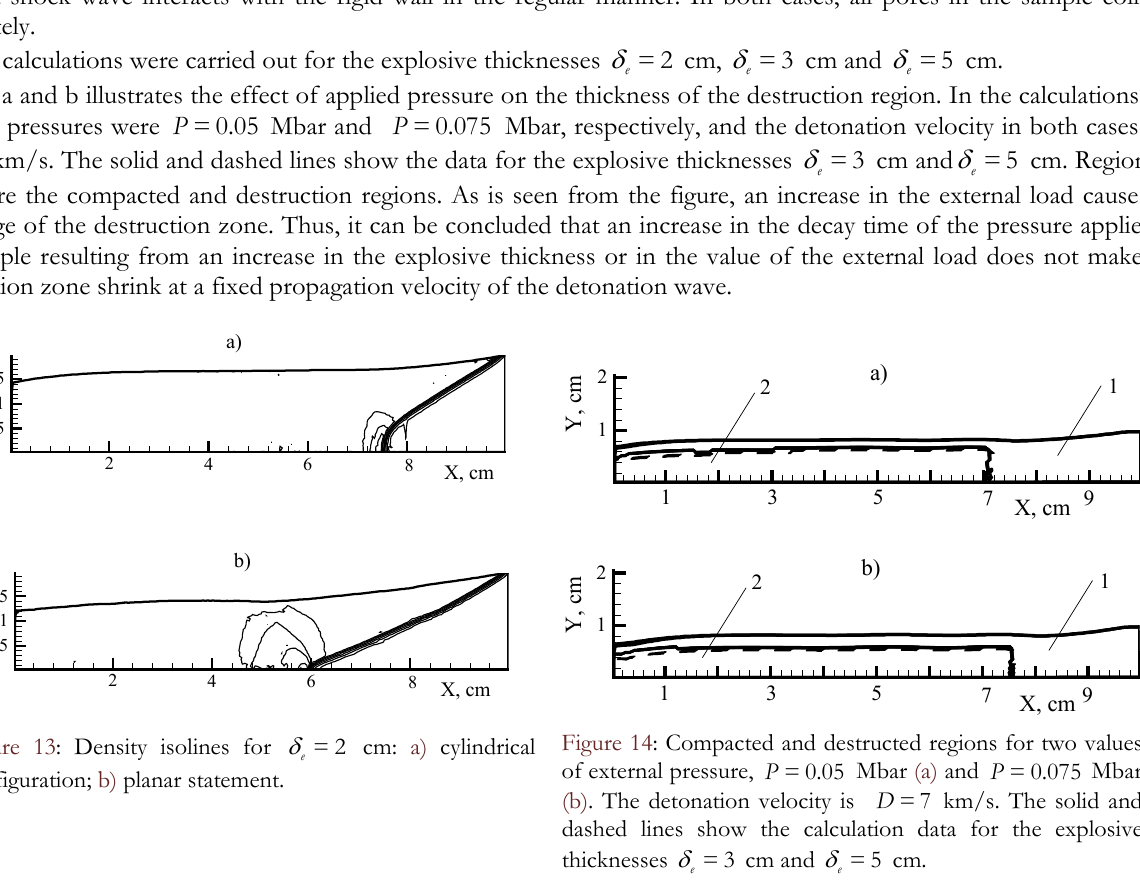
Figure 13: Density isolines for = 2 configuration; b) planar statement.